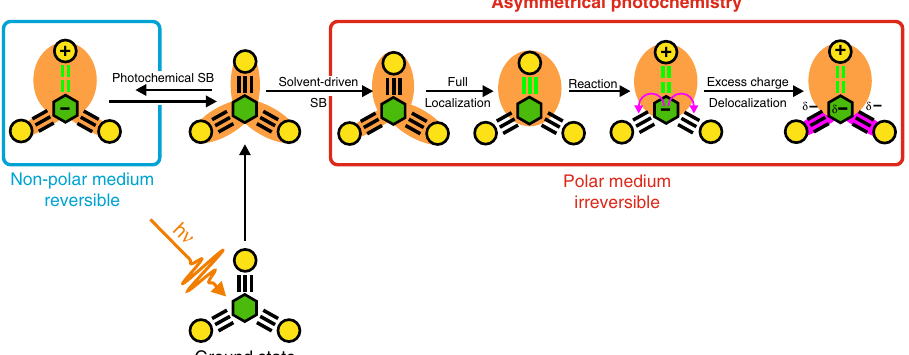
Fig. 7 Schematic representation of the excited-state processes in the octupolar dye O. Green hexagon represents the triazine electron acceptor, yellow circles are the electron donors and the orange shading stands for the electronic excitation. Photochemical symmetry breaking is reversible whereas solvent-driven SB is irreversible and leads to the ef fi cient funneling of the excitation into a single arm where it drives chemical reaction (charge separation coupled with the alkyne – allene isomerization). The excess negative charge acquired by the triazine unit as a result of the reaction is delocalized back into the spectator arms (magenta arrows and